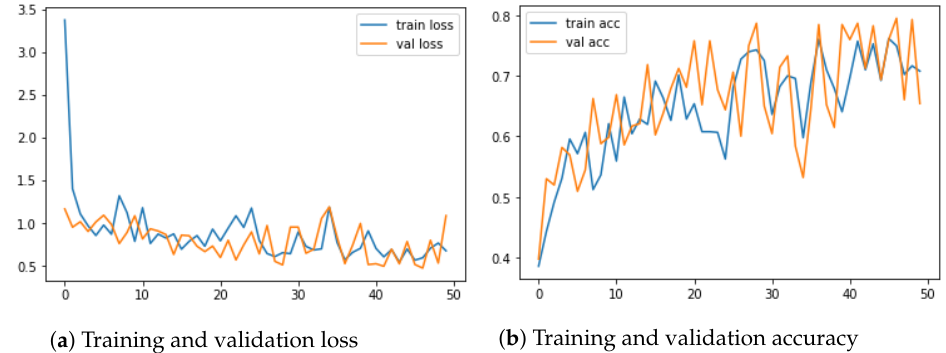
Figure 5. Classification performance of the Resnet50